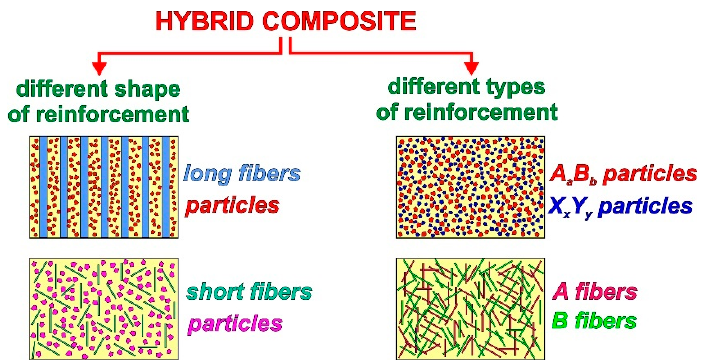
Figure 2. Scheme of various hybrid composites.